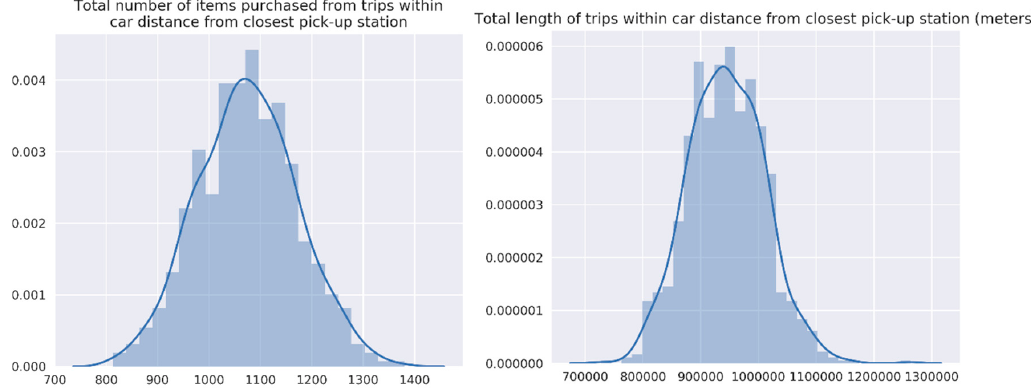
Figure 6. Total number of purchases from trips within biking distance.